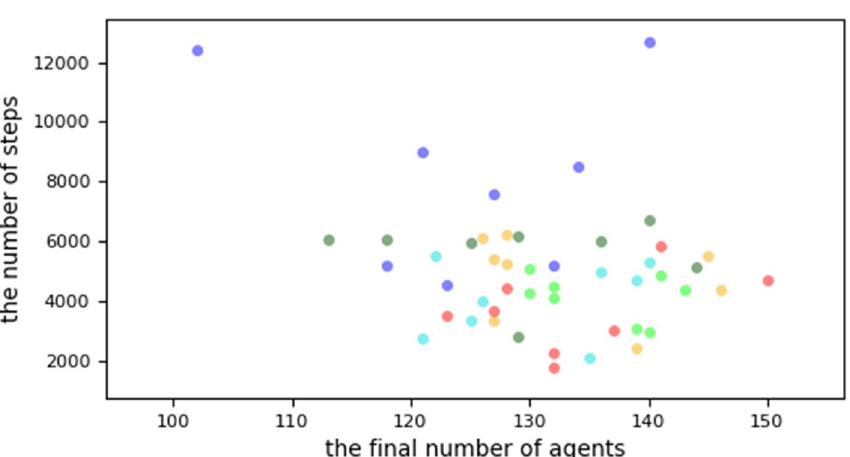
Figure 3. Different group dispersal ranges: (blue dots), group dispersal range = 30. (dark green dots), group dispersal range = 50. (sky blue dots), group dispersal range = 70. (light green dots), group dispersal range = 100. (orange dots), group dispersal range = 150. (red dots), group dispersal range = 200. Cheaters outcompeted cooperators in all of these runs. However, the extinction of cooperators is likely to be done more quickly, with fewer steps in the higher group dispersal